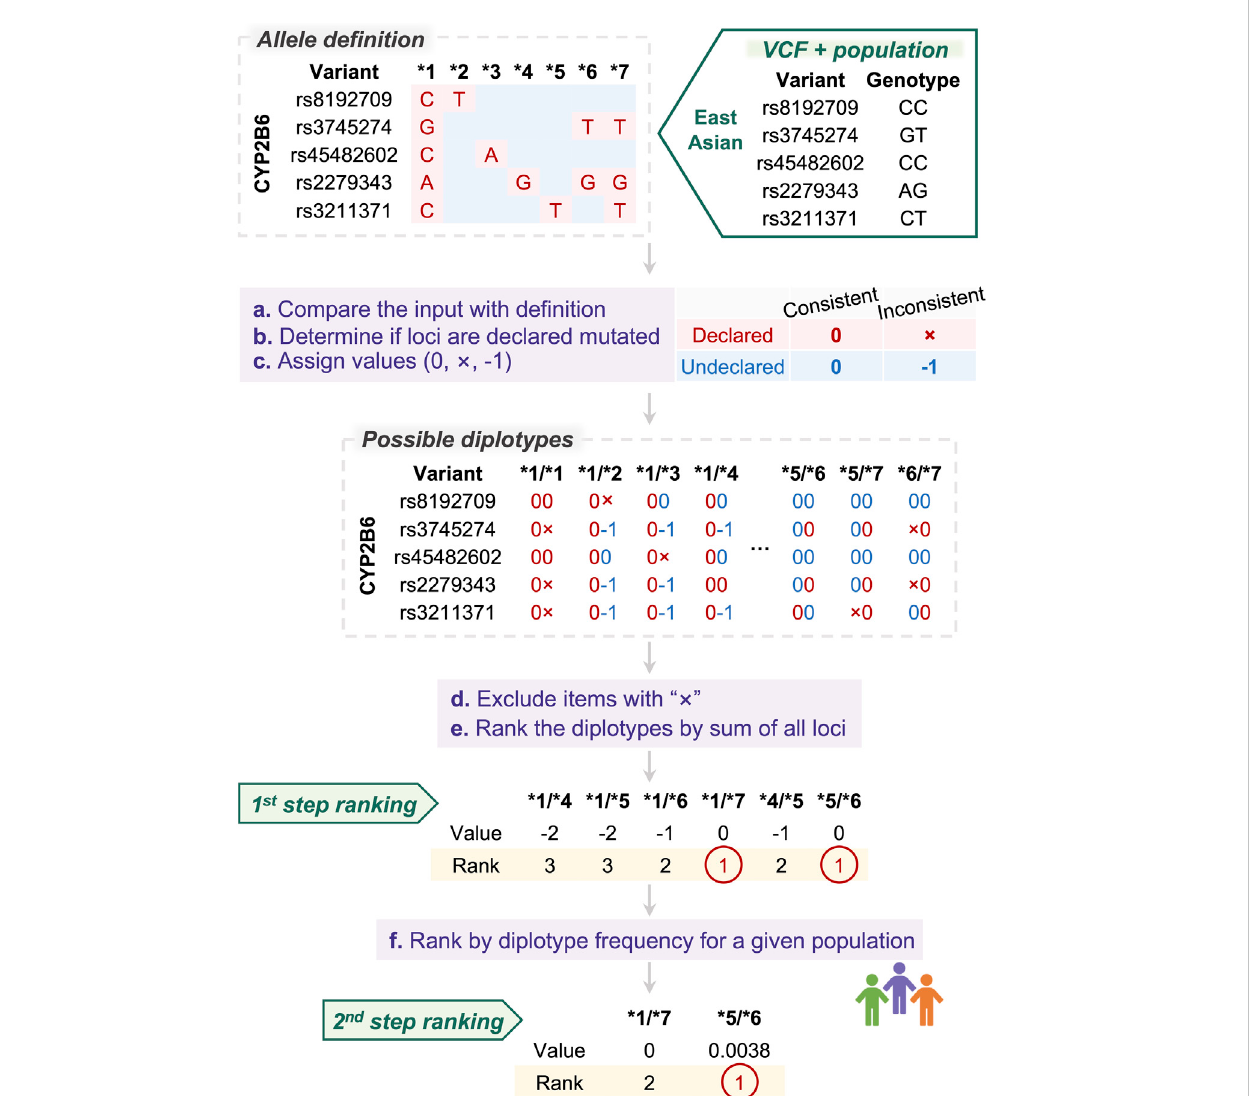
FIGURE 2 PAnnorankingmodelfordiplotypeinference.PAnnorankingmodelintegratesatwo-steprankingtodeterminethepriorityofdiplotypes.Inthe fi rststep, theconsistency of theinputalleles with thede fi nition ofcandidate diplotypesis calculated. Diplotypes with thehighestconcordanceare selected andranked in the second step based on frequency in a given population.